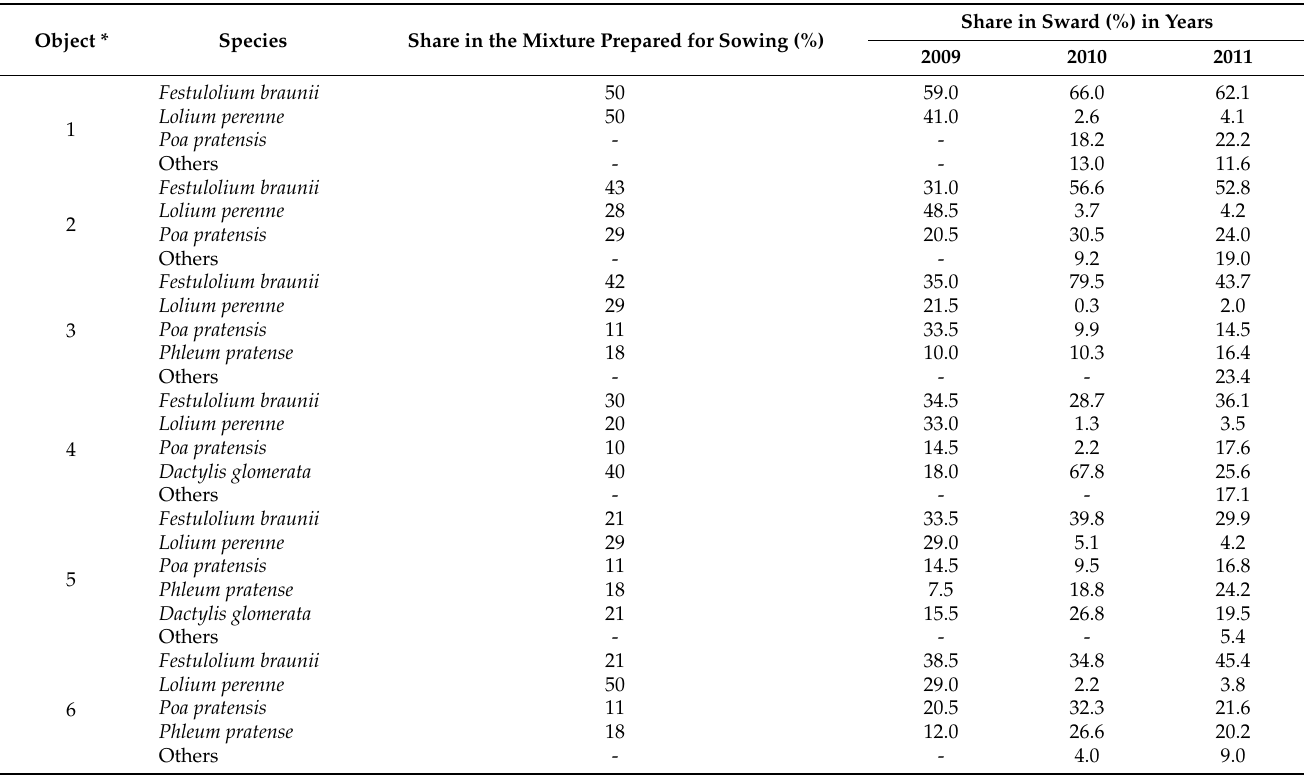
Table 4. Floristic composition of meadow sward (%) of experiment I from first cut in the years of research (2009–2011). Object * Species